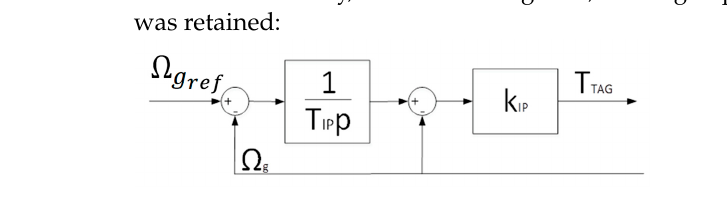
Figure 4. IP speed control of the gas turbine—generator association.